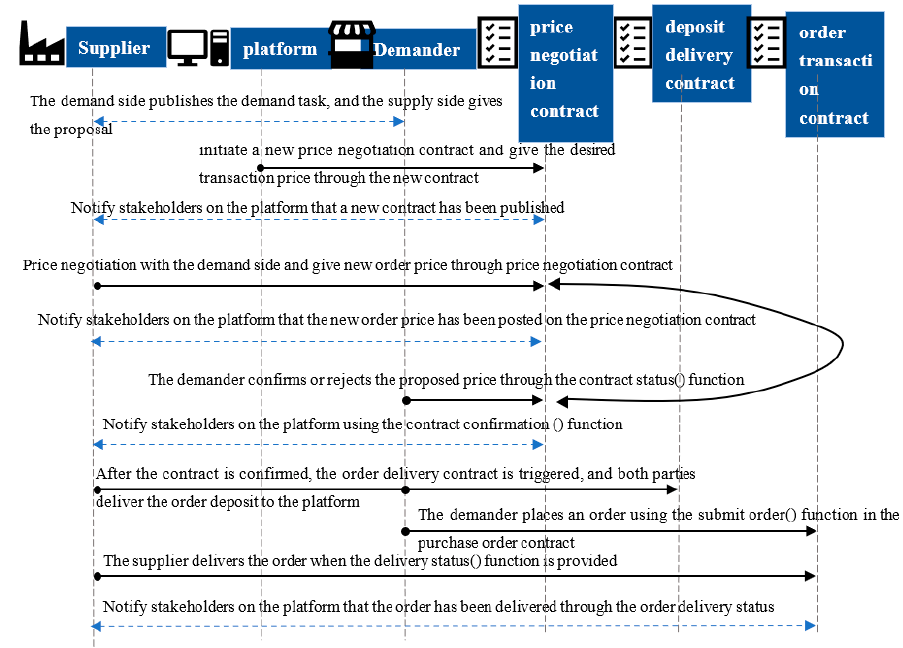
Figure 3. Function calls and events for stakeholder smart contracts in the platform.